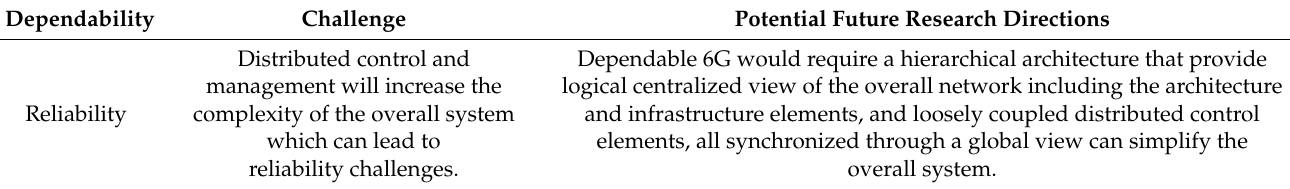
Table 1. Existing challenges and potential future research